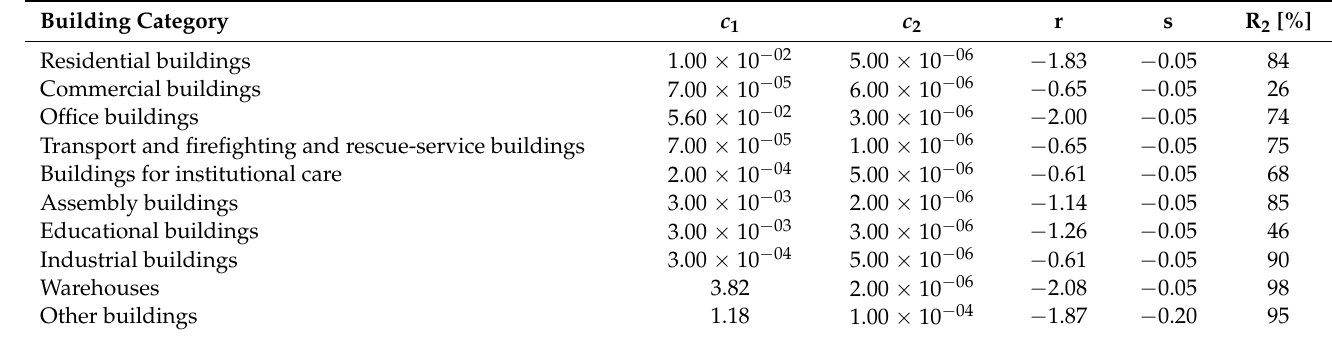
Table 5. Parameters of the generalized Barrois model extracted from Tillander [6].